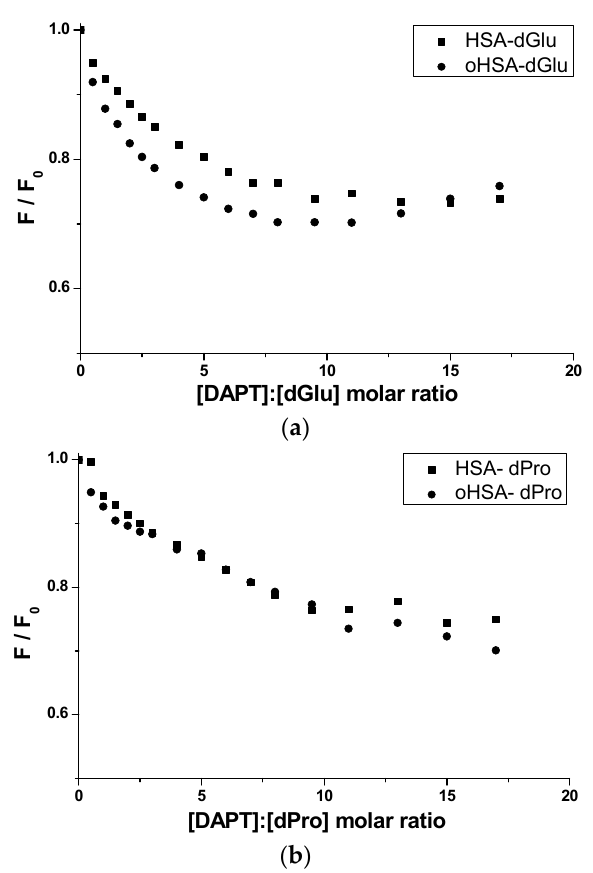
Figure 8. Comparison of quenching curves of ( a ) dGlu and ( b ) dPro at 5·10 − 6 mol·L − 1 concentration in the presence of HSA, oHSA at 5·10 − 6 mol·L − 1 concentration and DAPT (2.5 10 − 6 mol·L − 1 –8.5 10 − 5 mol·L − 1 ); the error calculated as maximum deviation does not exceed the symbols.